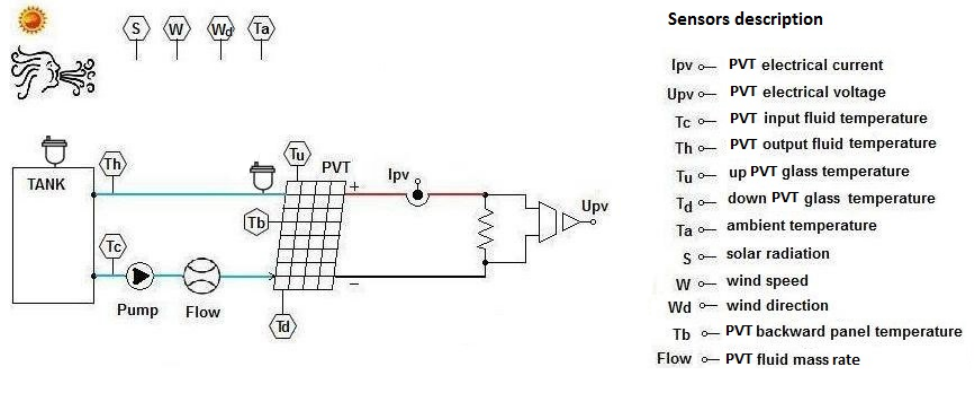
Figure 1: PVT main system.